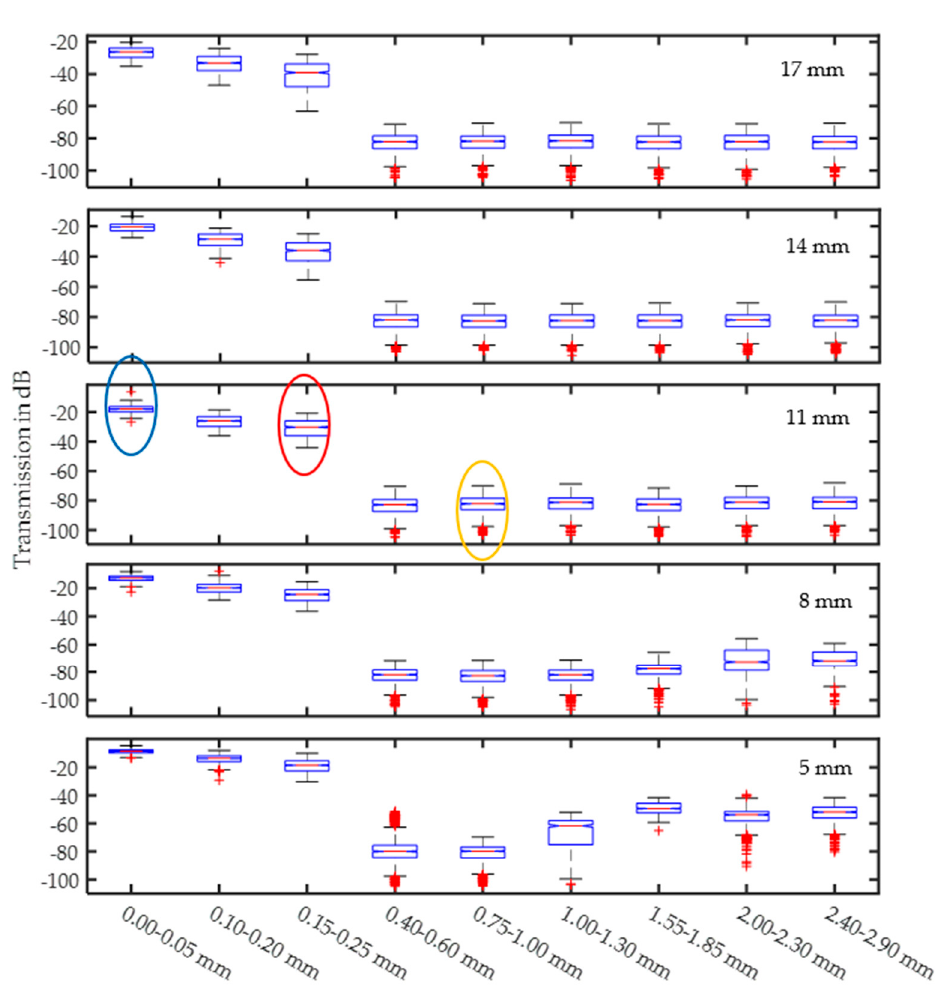
Figure 12. Averaged signal amplitudes for different glass fractions at different sample thicknesses.